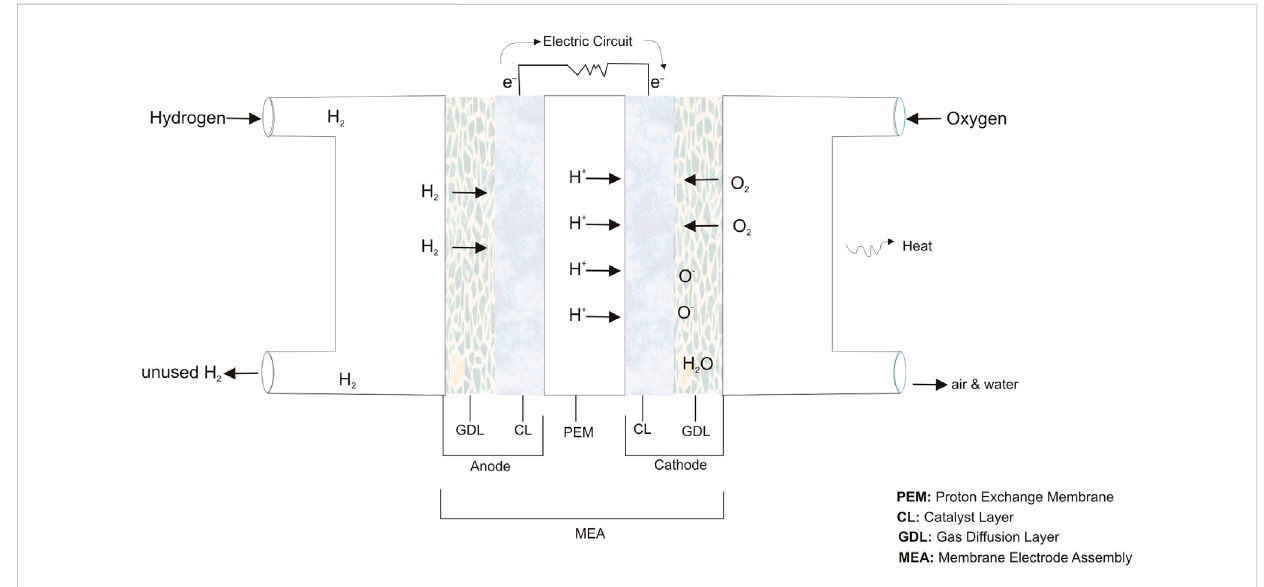
FIGURE 2 Representation of the role of electrocatalyst in HOR and ORR in